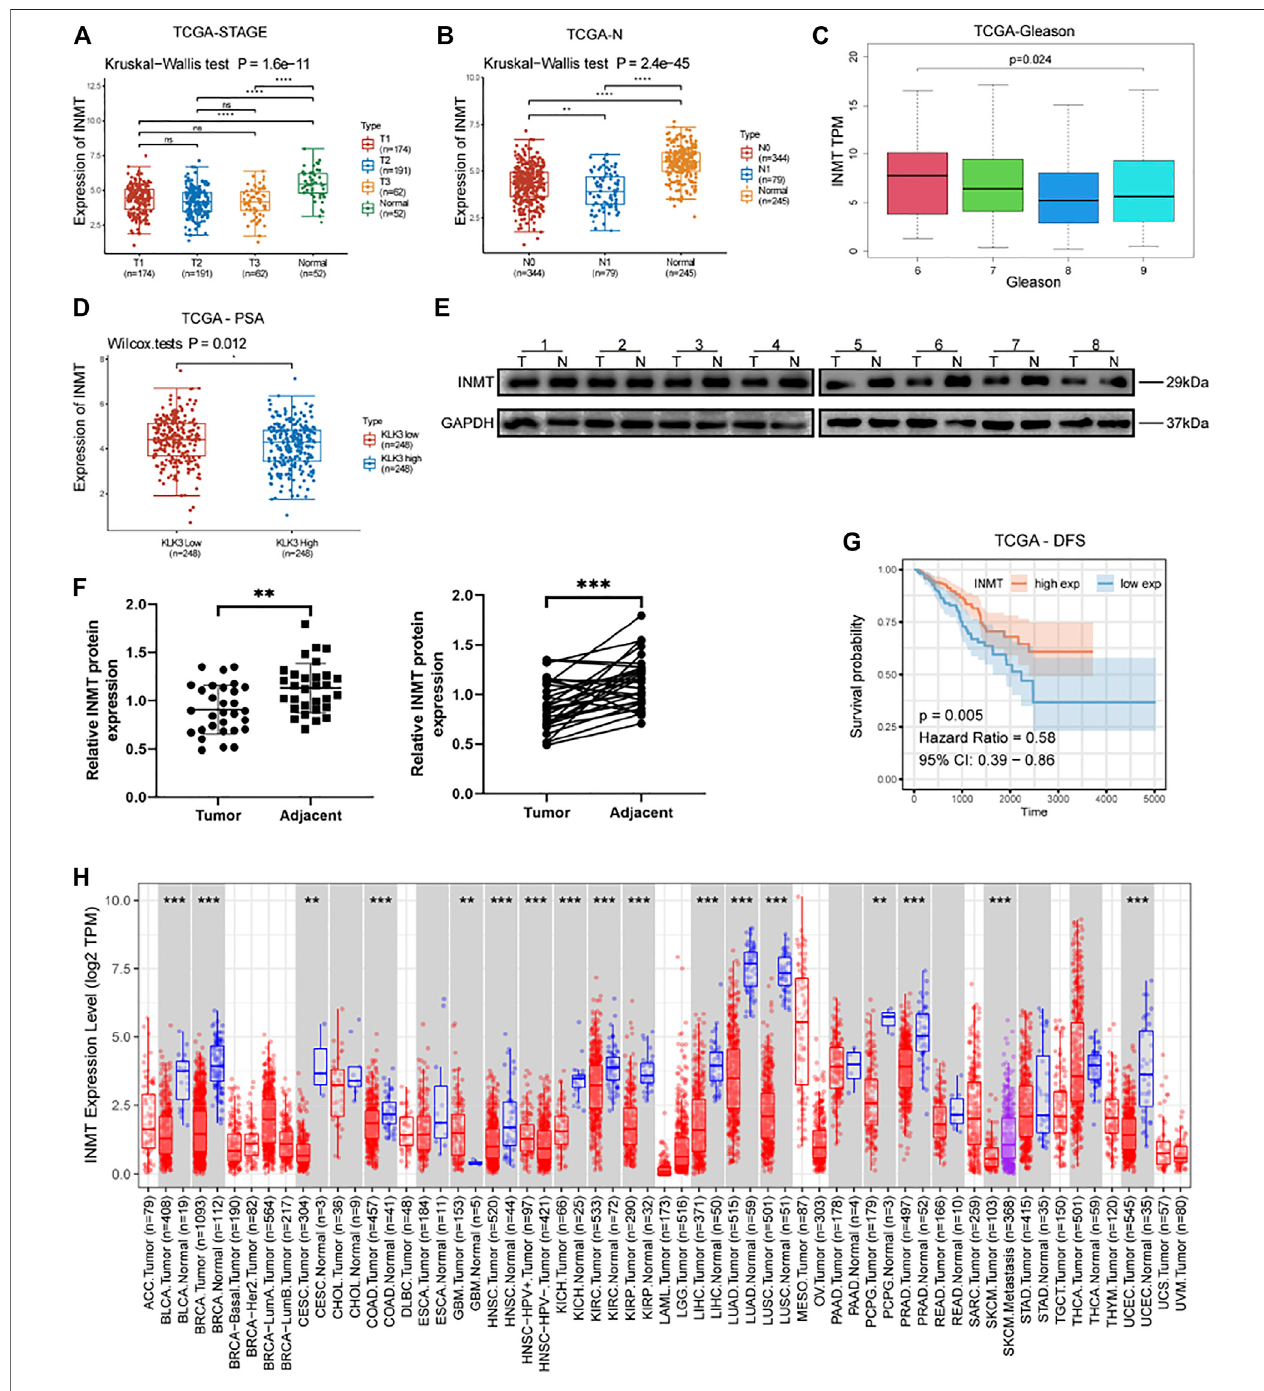
FIGURE 1 | (A) Expression of INMT in three clinical stages and normal prostate tissues of TCGA-PRAD ( p = 1.6e − 11), Tx classi fi cation according to TNM stage of prostate cancer (AJCC, 2017). (B) The expression of INMT in various lymph node metastasis groups and normal tissues of TCGA-PRAD ( p = 2.4e − 45). (C) The expression of INMT in various Gleason score groups of TCGA-PRAD ( p < 0.001). (D) The expression of INMT in the high PSA and low PSA groups of TCGA-PRAD ( p = 0.012). (E,F) The expression of INMT protein in 30 pairs of clinical samples of prostate cancer (T) and adjacent non-cancerous prostate tissues (N) ( p < 0.001). (G) Using survivalanalysis, wefound thatthe disease-free survivaltime inthe INMT high-expression group wassigni fi cantlylongerthan in the INMTlow-expression group in TCGA-PRAD ( p = 0.005, Hazard Ratio = 0.58). (H) Pan-cancer analysis of the TIMER database showing the expression level of INMT in cancer tissues.